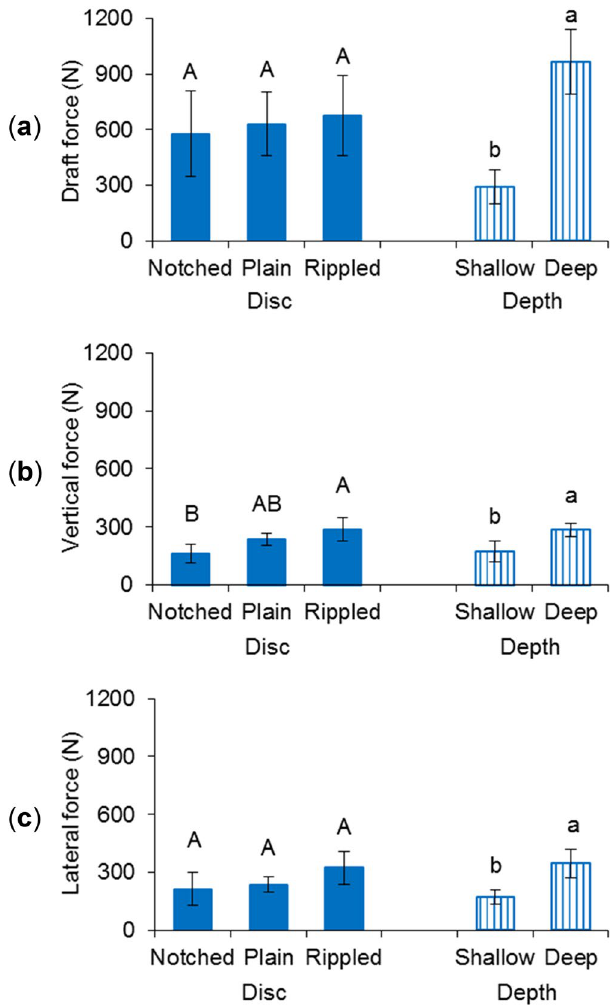
Figure 1. Soil cutting forces of different discs at different working depths: ( a ) draft force, ( b ) vertical force, and ( c ) lateral force; means followed by different lower case letters or upper case letters are significantly different according to Tukey’s test at the significance level of 0.05; error bars are standard